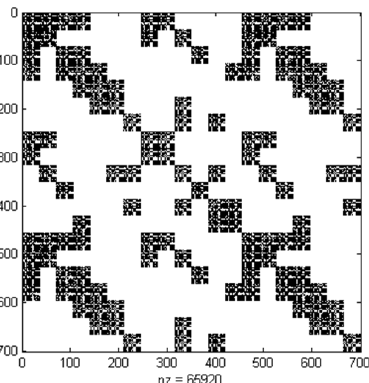
Figure 1. Structure of Jacobian matrix for an IEEE 14 ‐ bus test system with D = 4 before decoupling.